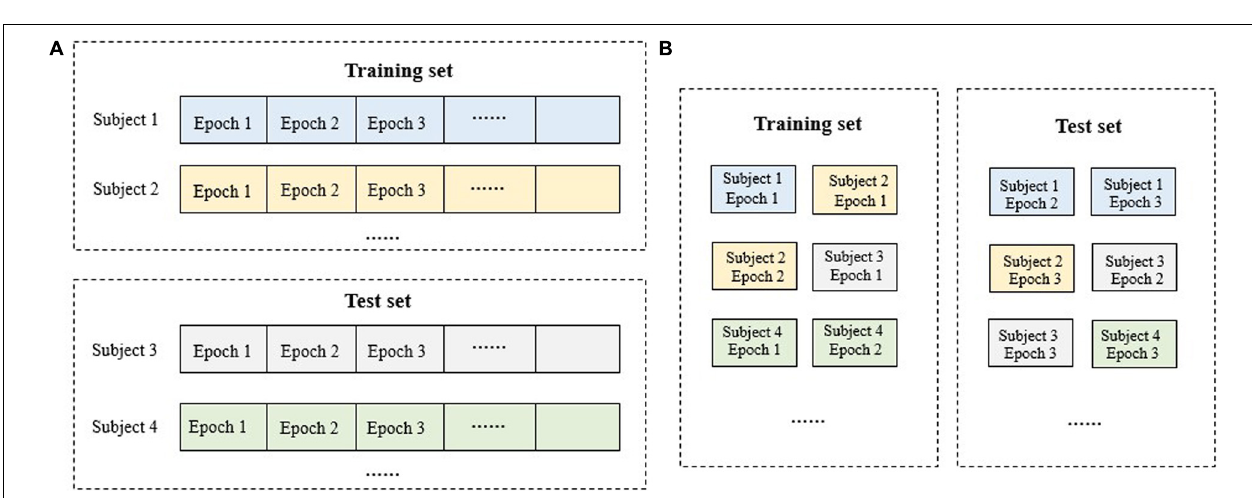
FIGURE 3 | Schematic diagram for the dataset splitting of training and test set: (A) subject-wise method; (B) epoch-wise method. For the subject-wise method, all the 30-s EEG epochs from a subject will be included in the training set or the test set as a whole while for the epoch-wise method, the epochs of a subject may appear in both the training and test